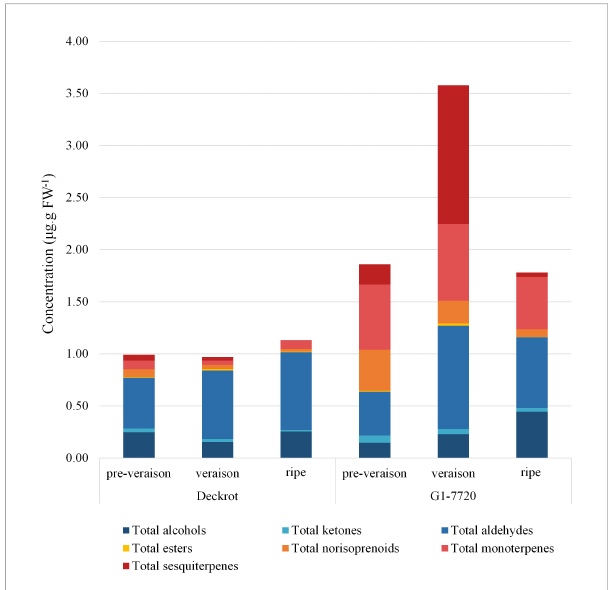
FIGURE 1 The volatile composition of the parent cultivars ‘ Deckrot ’ and G1- 7720 during pre-veraison, veraison and harvest ripe